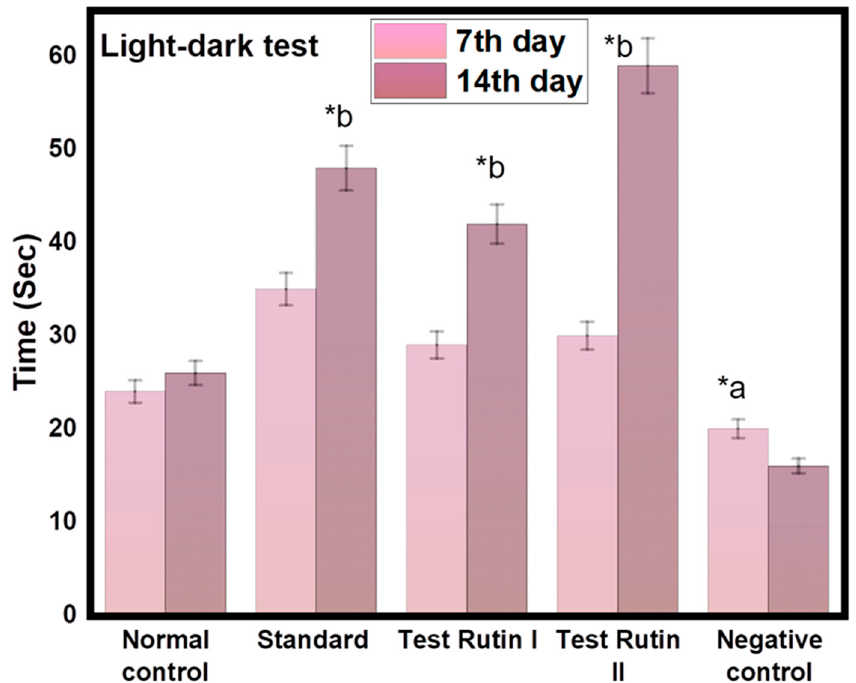
Figure 3. Effect of rutin pretreatment on antianxiety activity in rats using Light-dark test. The results are expressed as mean ± SD values ( n = 6). The significance of the difference was determined by two-way ANOVA; * p < 0.05 vs. respective controls. a = normal control vs. reserpine control; b = reserpine control vs.